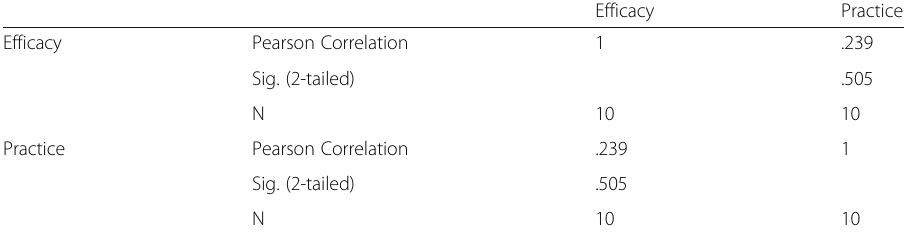
Table 4 Pearson Correlation Results for ELT Teachers ’ Self-efficacy and Instructional Practice